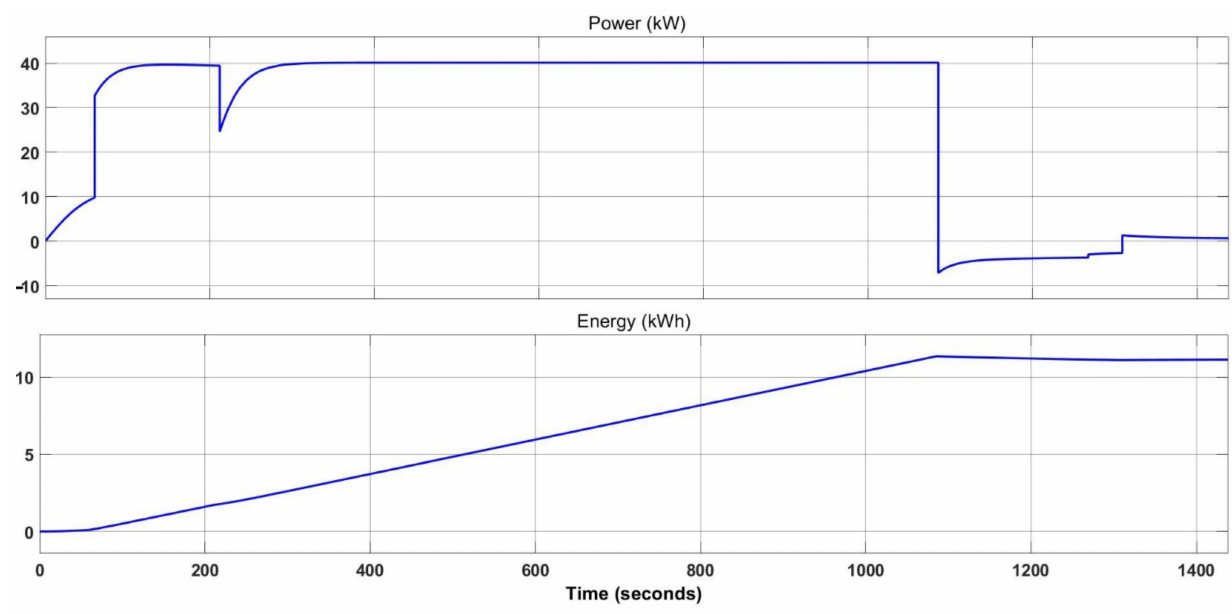
Figure 6. Power demand and energy consumption of electric Diamond DA20 Katana—cross country flight.